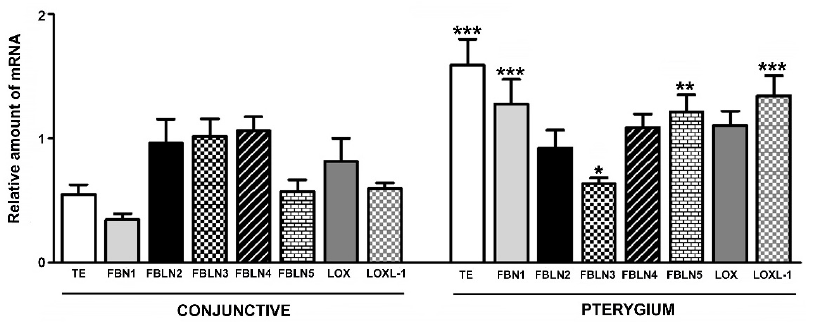
Figure 7. Relative quantification of tropoelastin (TE), fibrillin-1 (FBN1), fibulin-2 (FBLN2), fibulin-3 (FBLN3), fibulin-4 (FBLN4), fibulin-5 (FBLN5), LOX and LOXL1 messenger ribonucleic acid (mRNA) in conjunctival and pterygium tissue. Gene expression was normalized with glyceraldehyde 3-phosphate dehydrogenase (GAPDH). (* p < 0.05, ** p < 0.01, and *** p < 0.001).